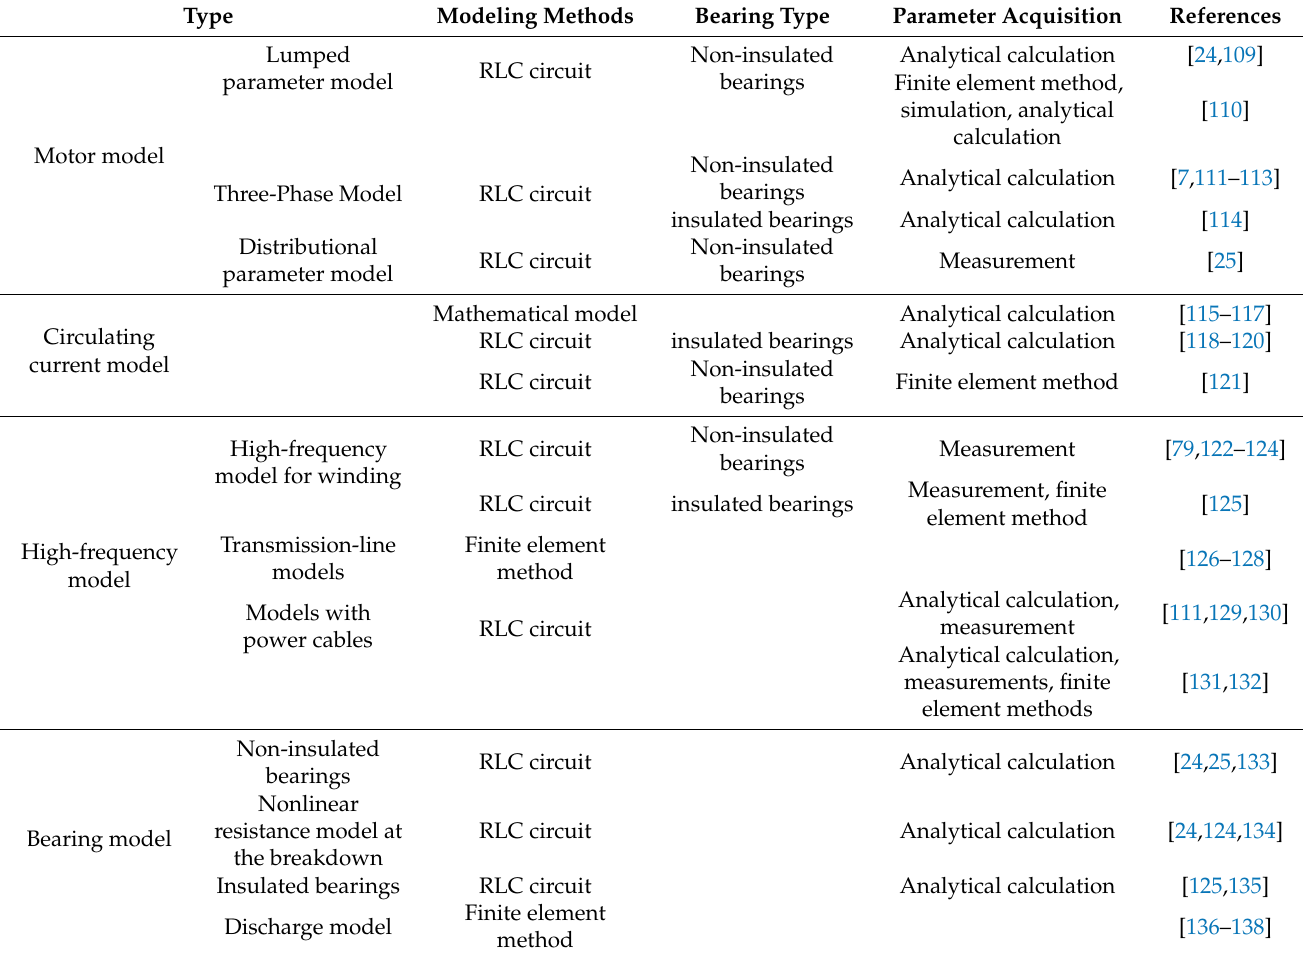
Table 1. Classification of motor shaft current